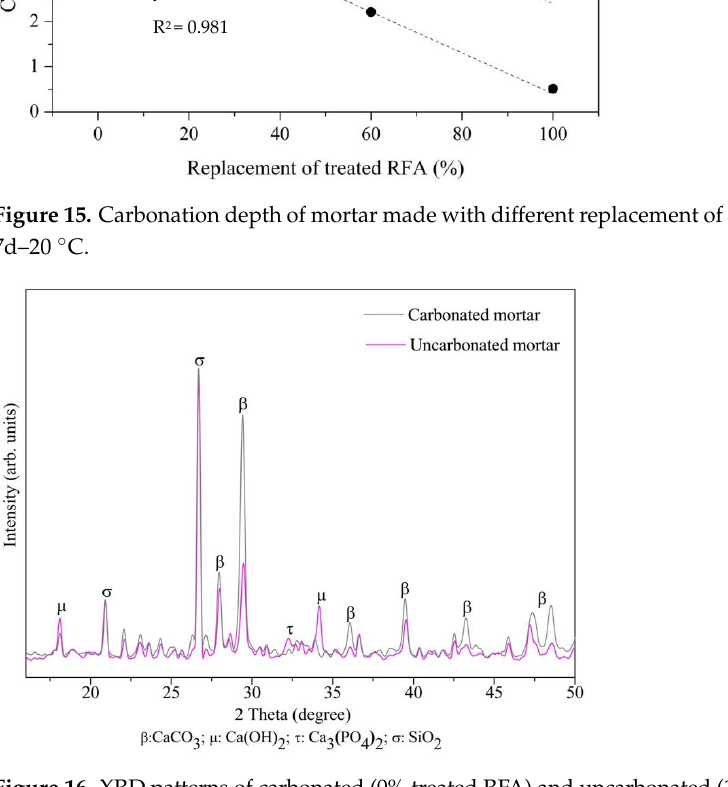
Figure 15. Carbonation depth of mortar made with different replacement of treated RFA at 0.5mol/L – 7d – 20 °C.